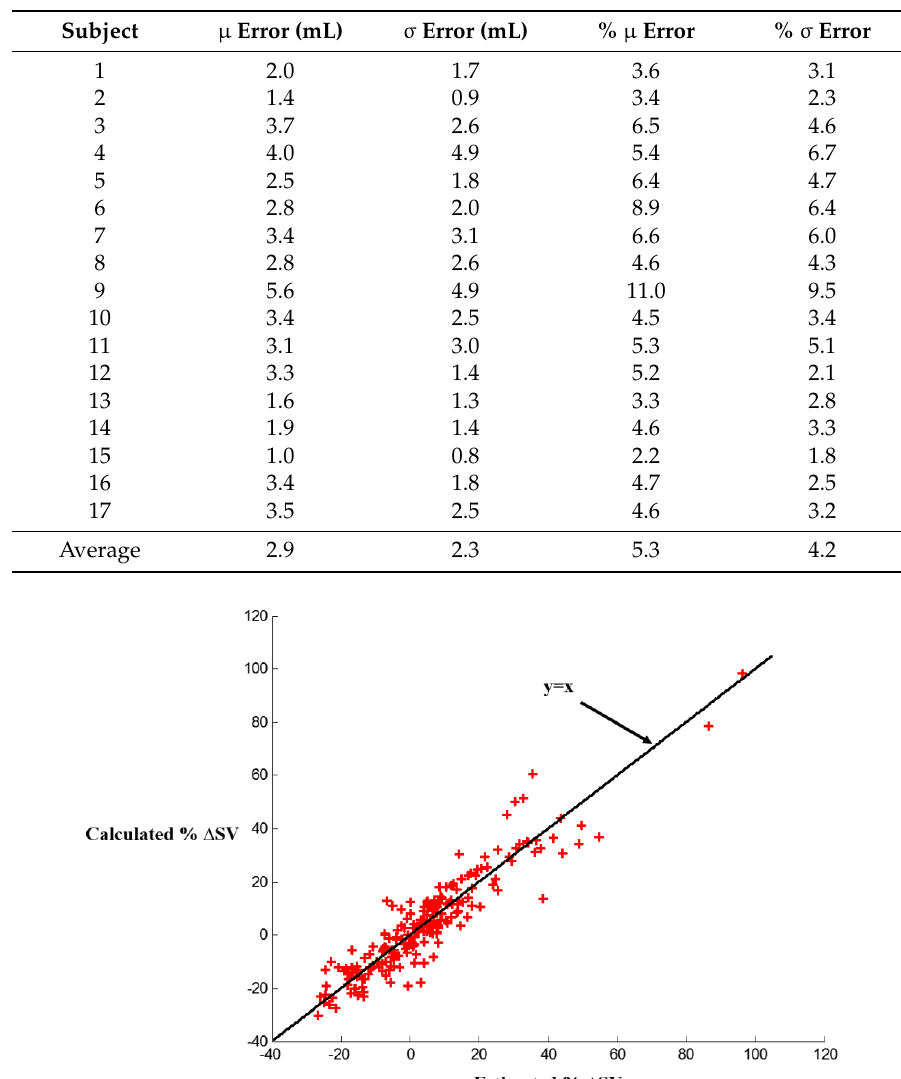
Figure 6. Estimated stroke volume percent changes from head-to-foot force plate BCG compared to calculated stroke volume percent changes from reference